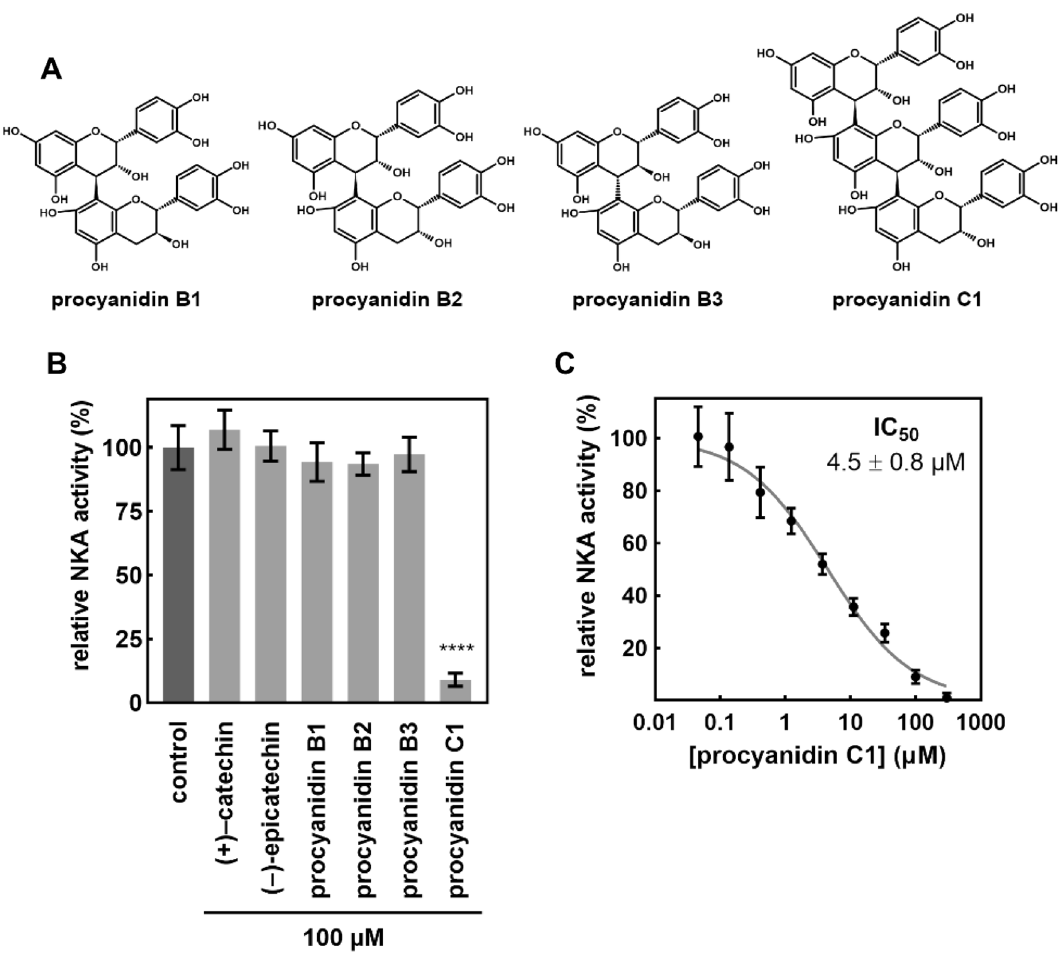
Figure 2 . ( A ) Chemical structures of tested procyanidins. ( B ) Relative NKA activity (%) of NKA treated with flavan-3-ols and B-type procyanidin dimers and trimer. Data are expressed as means ± SD (n = 4). Statistical significance based on Tukey’s test is indicated by **** for p < 0.0001. ( C ) Dose–response curve for NKA inhibition by procyanidin C1. Data are expressed as means ± SD (n =